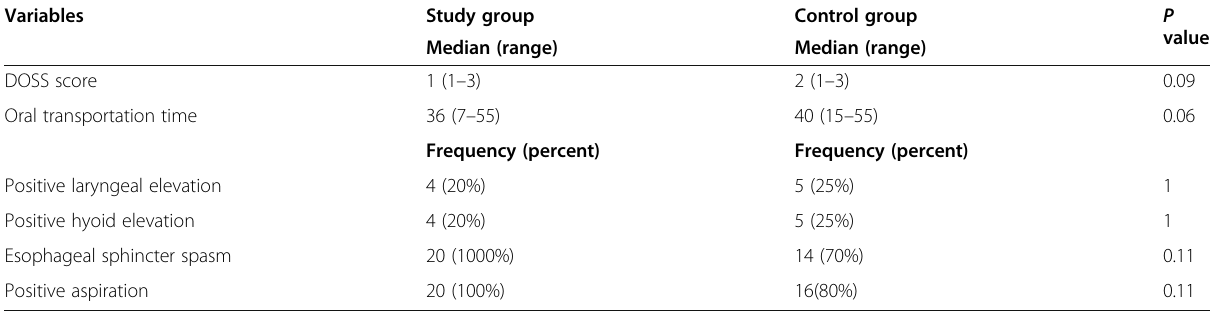
Table 4 Comparison of the DOSS score and different components of the digital fluoroscopic evaluation pre-treatment between both groups A and B Variables